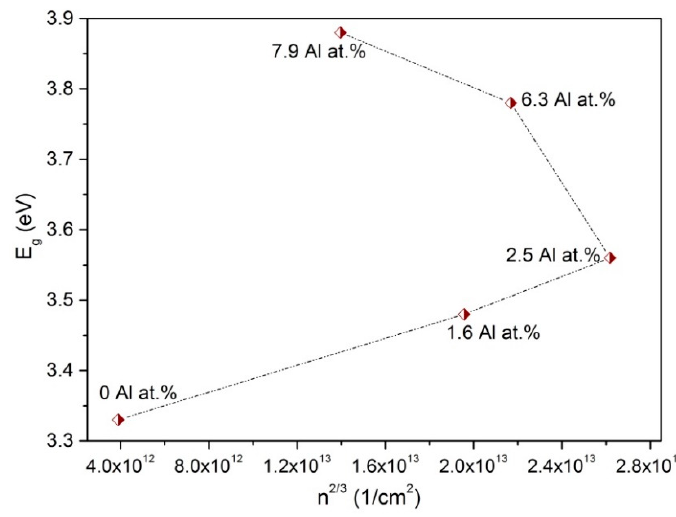
Figure 13. Optical band gap vs. (carrier concentration n ) 2/3 for AZO films.